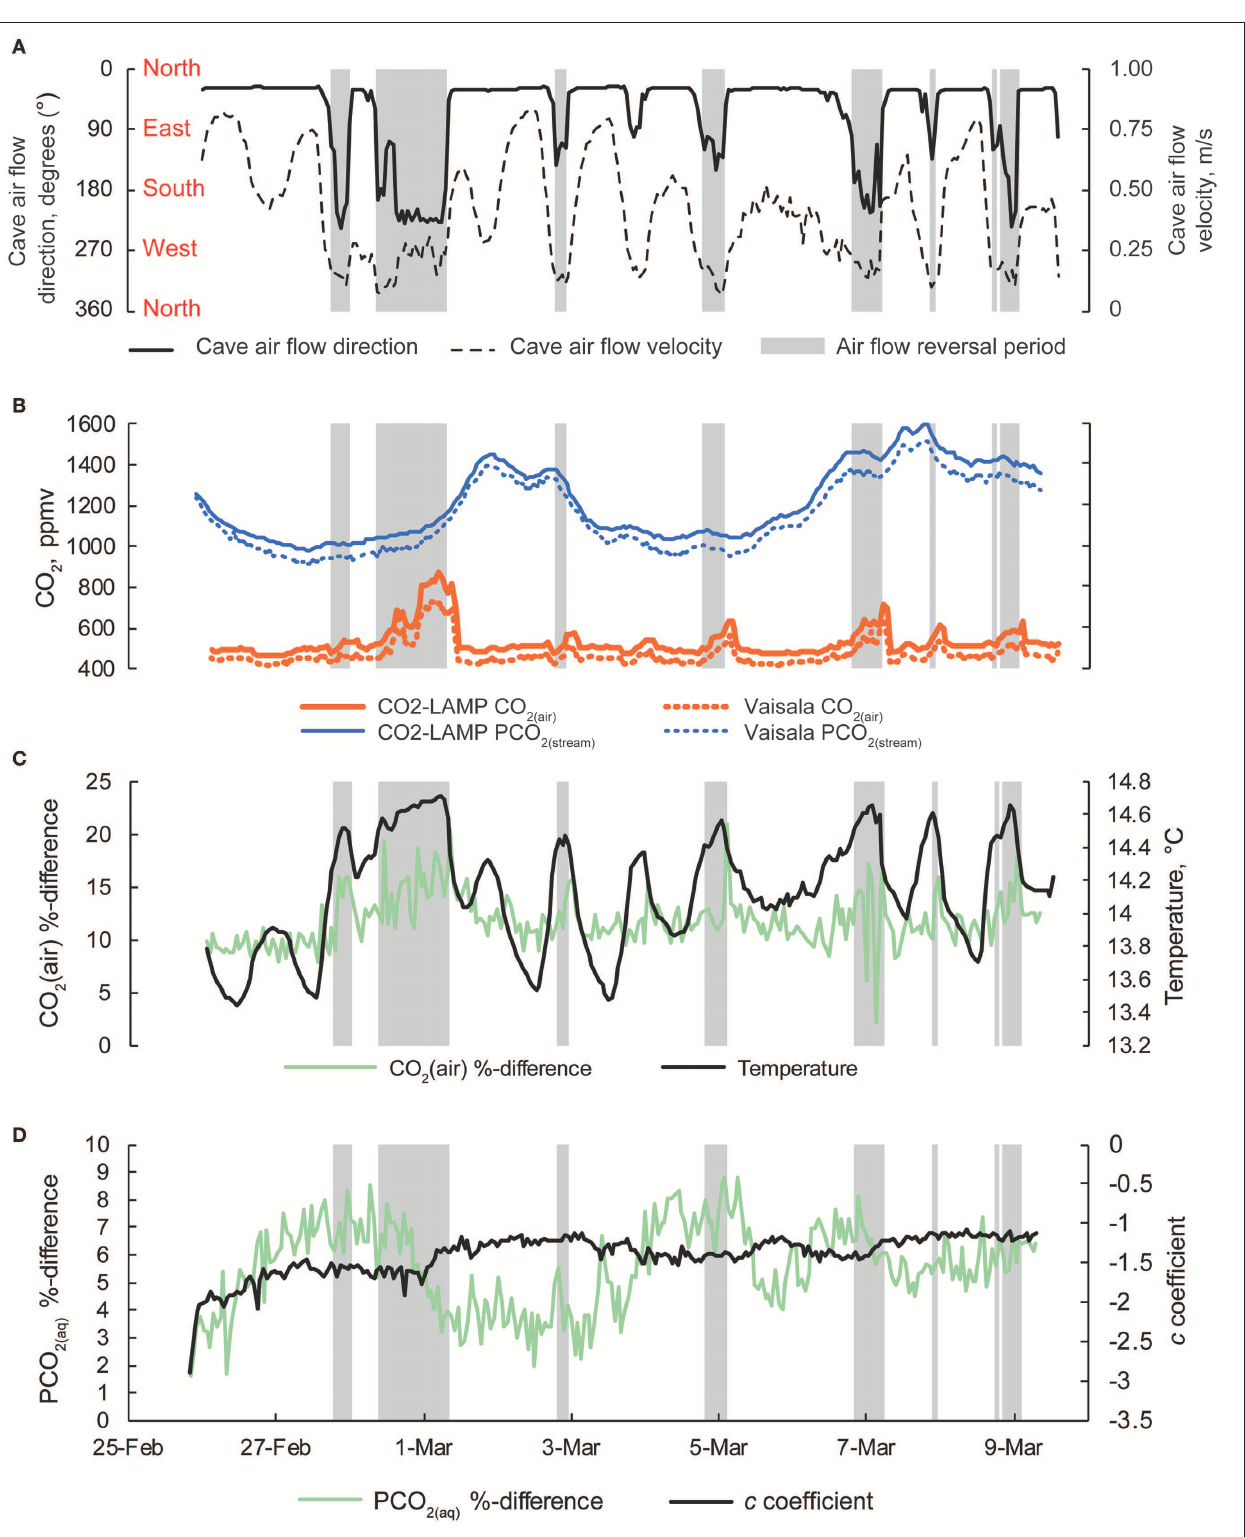
FIGURE 9 | (A) Cave air flow direction and cave air flow velocity. Cardinal directions are shown. Periods when cave air flow direction are > 100 ◦ are shaded gray in all panels. (B) Concurrent measurements of CO 2(air) and PCO 2(stream) collected by the CO2-LAMP and Vaisala platforms from 26 February to 9 March, 2017. (C) Percent difference for CO 2(air) between the CO2-LAMP and Vaisala and changes in cave air temperature over the monitoring period. (D) Percent differences for PCO 2(stream) between the CO2-LAMP and Vaisala and changes in curvature (i.e., c coefficient) derived from the Hill-equation.